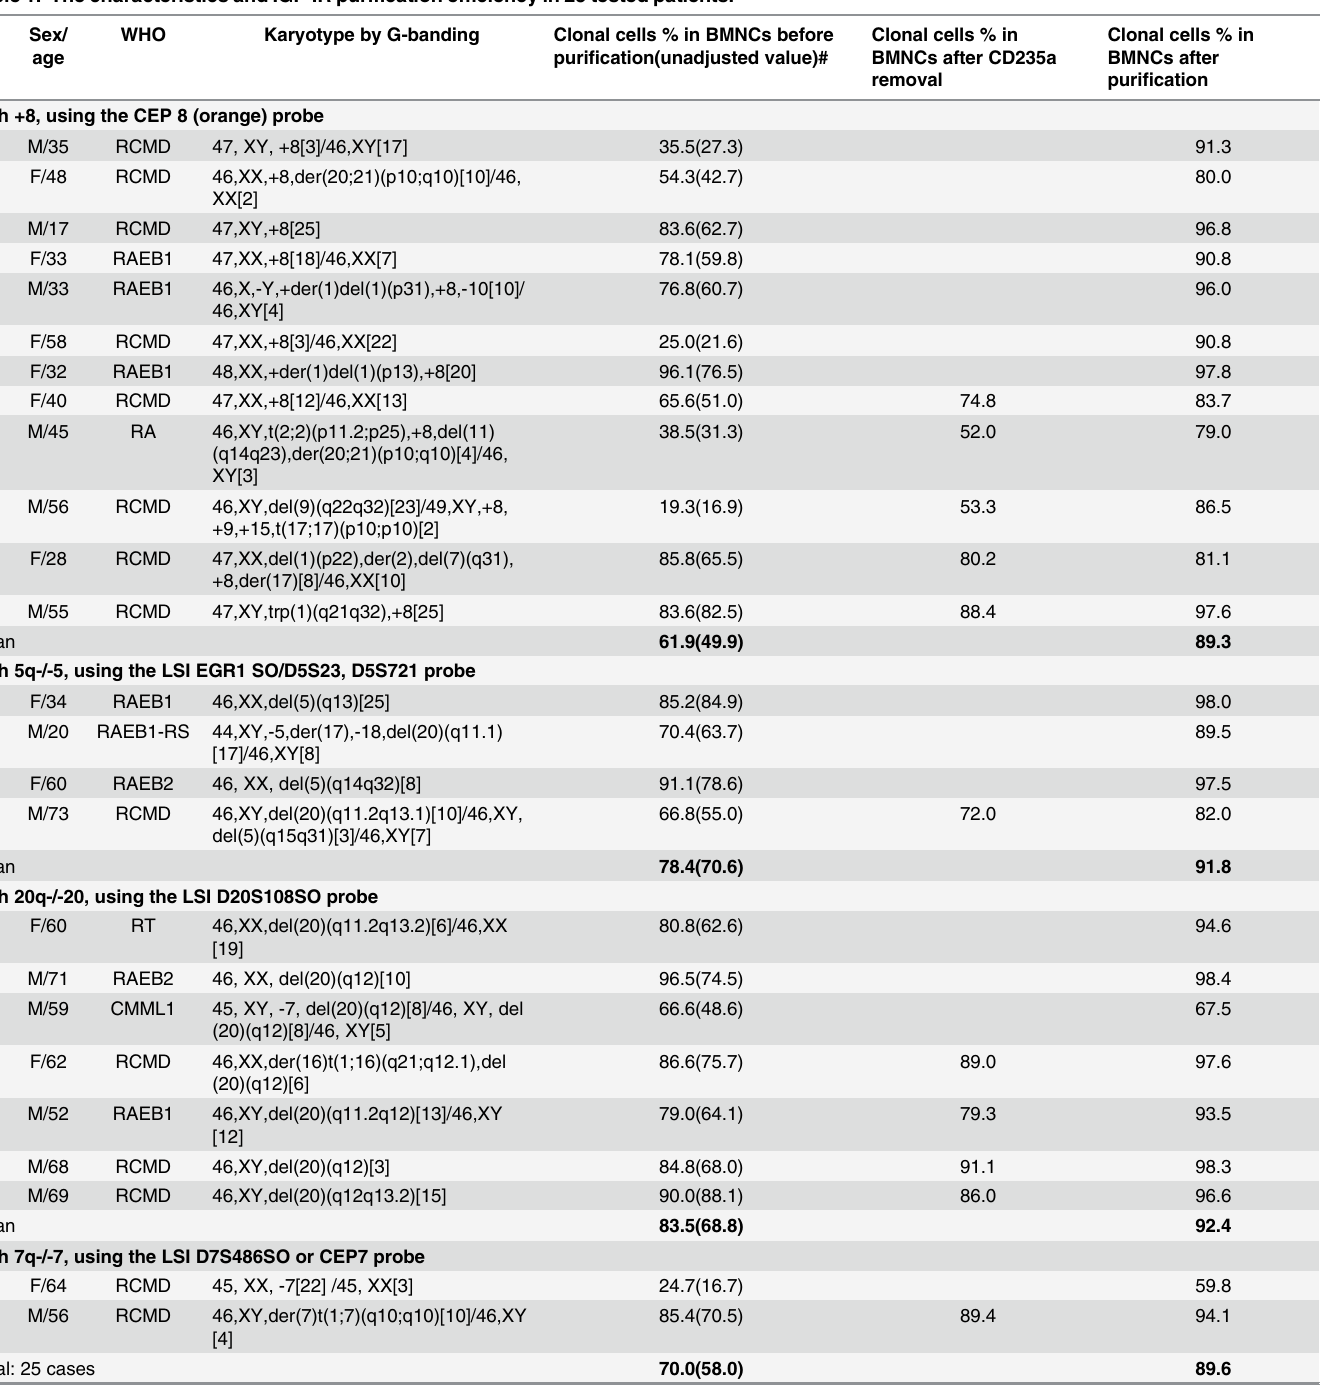
Table 1. The characteristics and IGF-IR purification efficiency in 25 tested patients. Sex/ WHO Karyotype by G-banding Clonal cells % in BMNCs before age